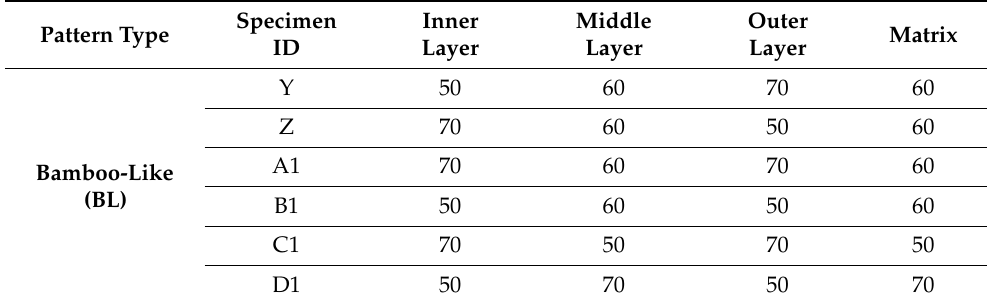
Figure 7. Bamboo-Like (BL) pattern arrangement. In a cross-sectional view, the dimensions of each layer are reported. Table 3. Shore A hardness values were assigned for each layer of the Bamboo-Like (BL) pattern. The range considered was from 50 (medium-soft) to 70 (hard-soft).